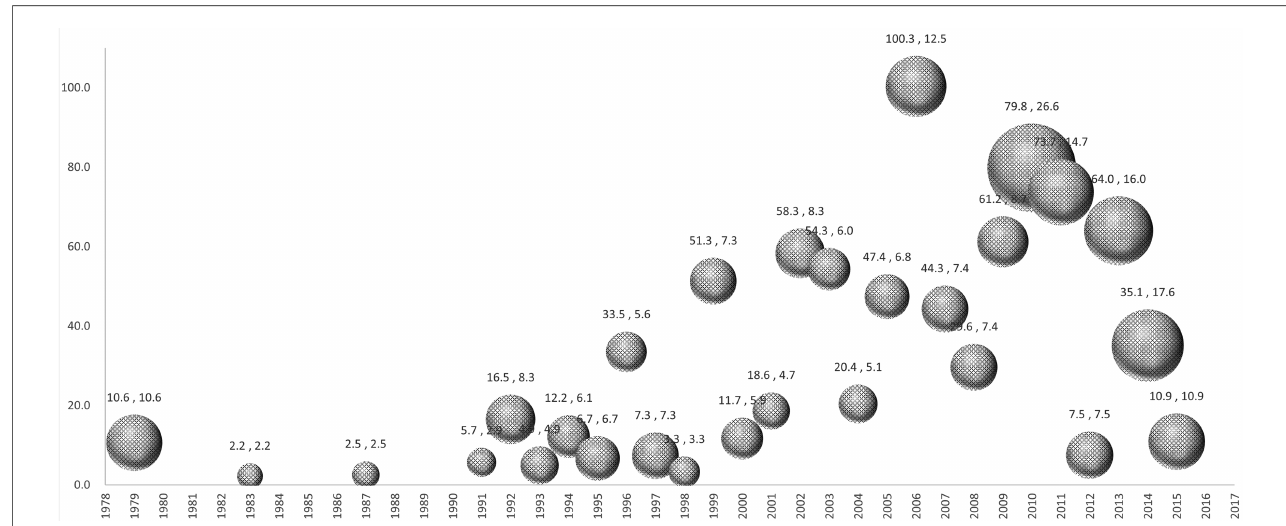
FIGURE 2 Bubble plot of publication year and mean citation density. Note: The X-axis represents the time range of occurrence of the top 100 cited articles, the Y-axis represents the total citation density, and the bubble size represents the average citation density of each article per year. In the data label, the former is the Y-axis value and the latter is the bubble size